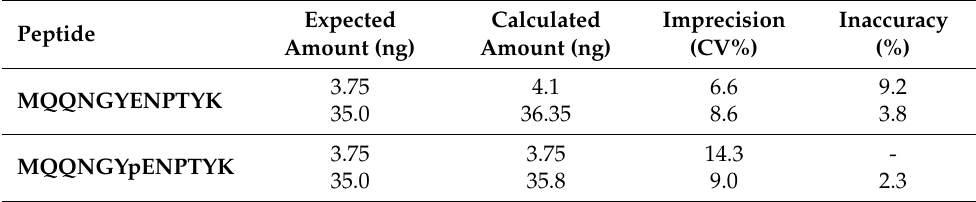
Table 4. Between-day imprecision (CV%) and inaccuracy (%) of results obtained by measuring two QC levels once a day for five days ( n =